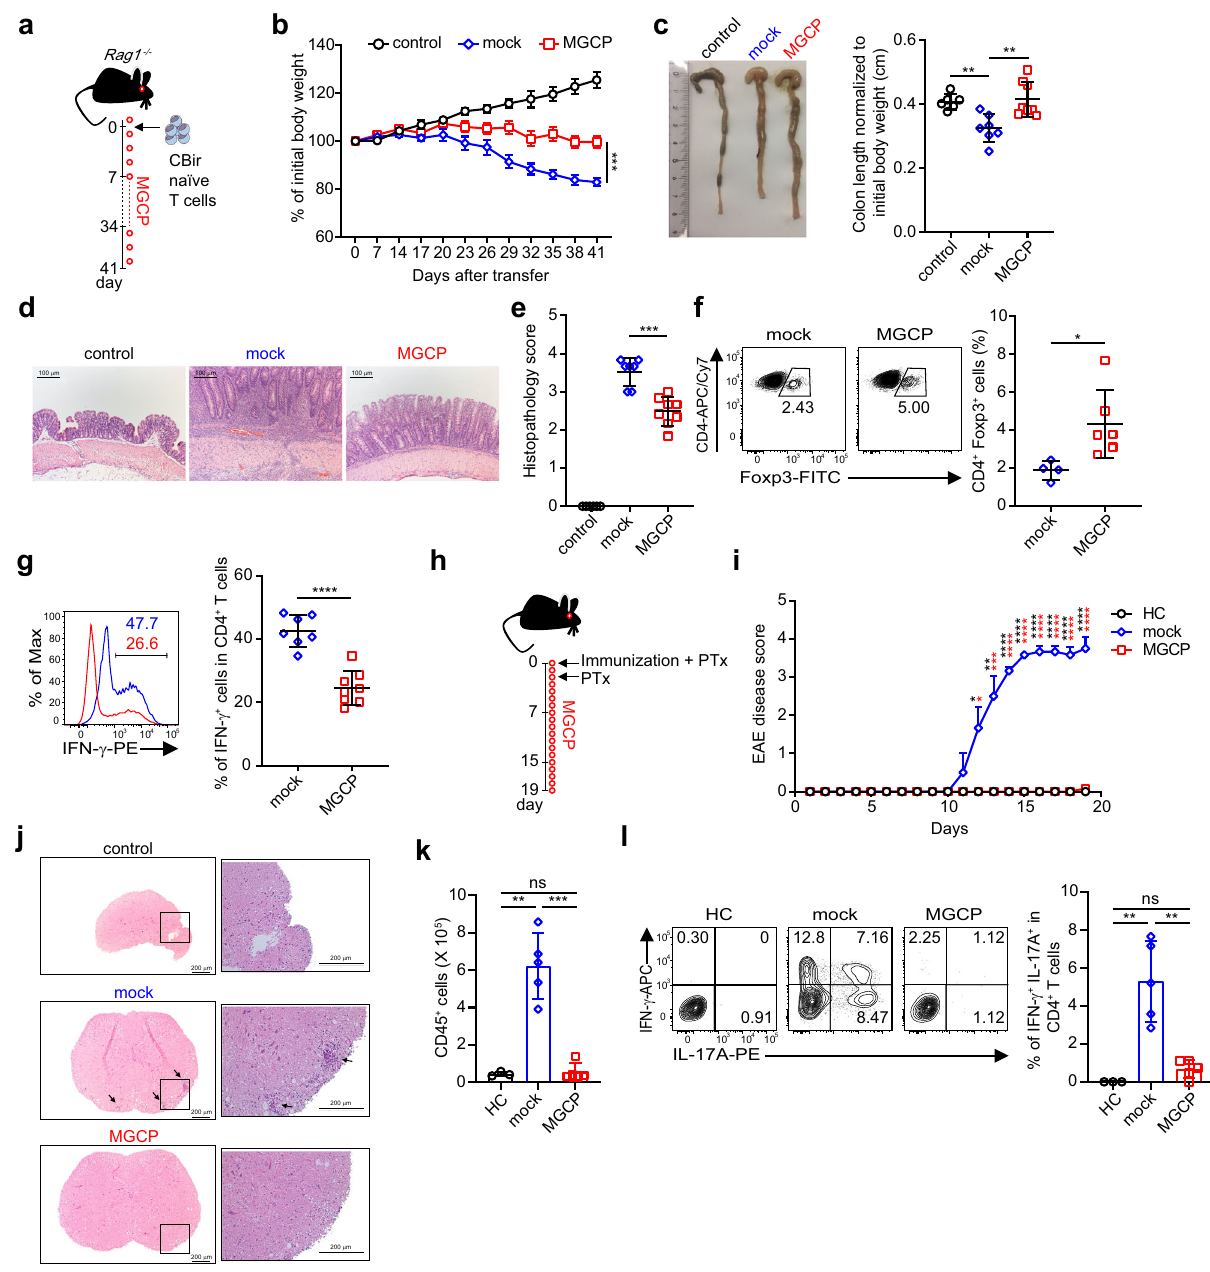
Fig. 5 MGCP supplementation ameliorates experimental in fl ammatory diseases. a Schematic of experimental model of colitis employed. Naive CD4 + T cells (CD4 + Foxp3 − CD44 lo CD62L hi ) isolated from CBir mice were adoptively transferred into Rag1 de fi cient mice. MGCP, or distilled water as mock, was fed every other day from a day before transferring the cells and continued for entire experimental period. b Body weight change as a measure of colitis development is shown. Data are analyzed with minimum 6 mice from 2 independent experiments. c Representative image of colon (left) and colon length normalized to initial body weight (right). Each dot represents individual mouse. d Representative colon histology image after hematoxylin and eosin (H&E) staining. e Histopathology score of colitis. f Representative FACS plots (left) and frequencies (right) of CD4 + Foxp3 + T cells in colon. g Representative histogram (left) and frequency (right) of IFN- γ producing colonic effector CD4 + T cells (CD4 + Foxp3 − ). Data are analyzed from pooled data with minimum 6 mice ( c , e ) and 7 mice ( g ) or representative result with minimum 4 mice ( f ) of 2 independent experiments. Each dot represents an individual mouse. h Scheme of EAE experiment. Mice were immunized with MOG 35 – 55 and complete Freund ’ s adjuvant (CFA) to develop EAE as described in “ Methods ” . Immunized mice were injected daily with MGCP, or distilled water as mock, from the day of immunization. i Graphical display of EAE clinical scores for each treatment groups. Data are presented with representative result of 2 independent experiments with minimum 3 mice. Statistical signi fi cance was measured by one-way ANOVA with Turkey ’ s multiple comparison test. j Representative spinal cord sections stained with H&E. Magni fi cations, ×5 (left) and ×20 (right). Arrows indicate in fi ltrated lymphocytes. k Absolute numbers of in fi ltrating lymphocytes in spinal cords of the different treated groups. Data are presented with representative result of 2 independent experiments with minimum 3 mice. l Representative fl ow cytometric plots (right) and percentage (left) of CD4 + IFN- γ + IL-17A + T cells in the spinal cords of indicated groups of mice. Each dot represents an individual mouse. Data from one of three independent experiments with minimum 3 mice is shown. Graphs show mean ± SEM. b , i * p < 0.05, ** p < 0.01, *** p < 0.001, **** p < 0.0001 or ±SD. c , e , f , g , k – l * p < 0.05, ** p < 0.01, *** p < 0.001, **** p < 0.0001 (two-tailed student ’ s t test). ns: not signi fi cant. Source data are provided as a Source data fi